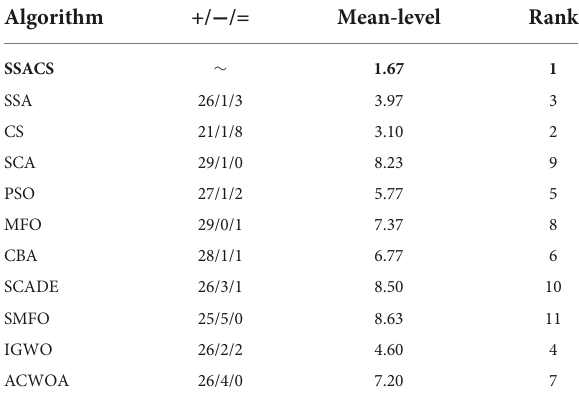
TABLE 6 Wilcoxon signed-rank results.